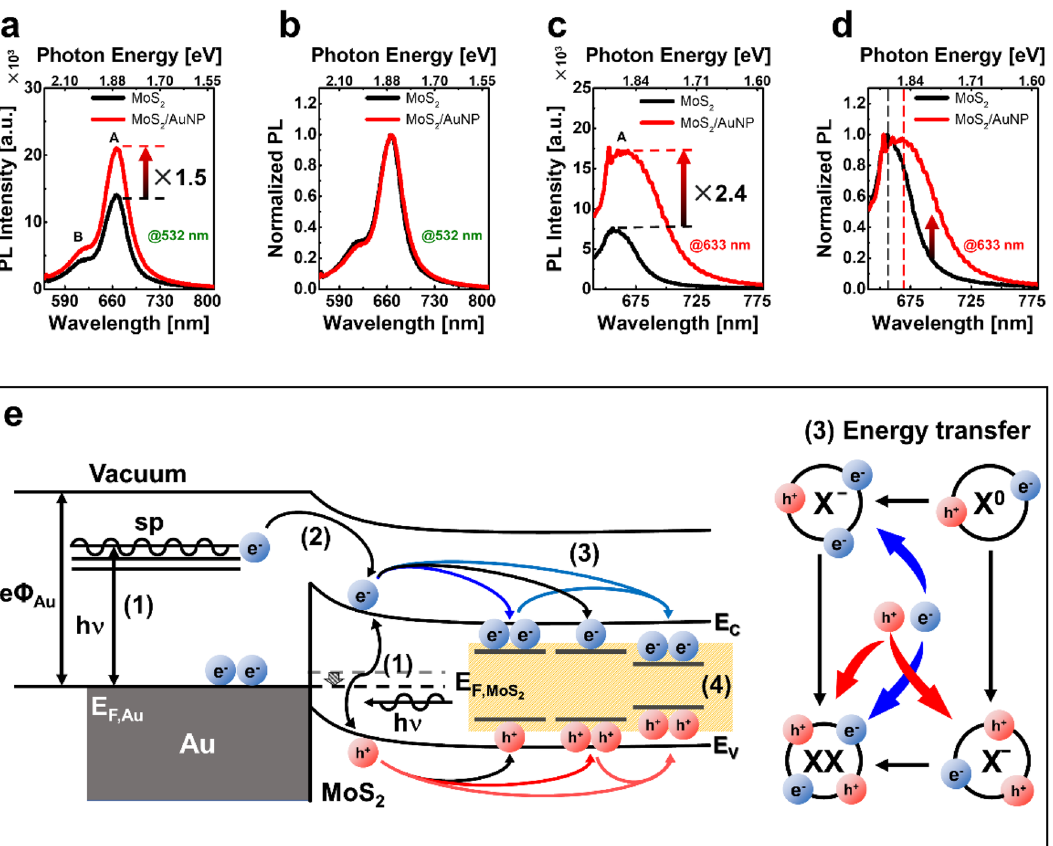
Figure 2. PL spectra of 532 nm and 632.8 nm excitation and mechanism of plasmon-exciton coupling. PL spectra for ( a ) 532 nm and ( c ) 632.8 nm excitation. Normalized PL spectra for ( b ) 532 nm and ( d ) 632.8 nm excitation. ( e ) Schematics of plasmon-exciton coupling mechanisms of each exciton mode on the MoS 2 /AuNP hybrid. (1) excitation process. (2) energy transfer. (3) recombination process. (4) EM field